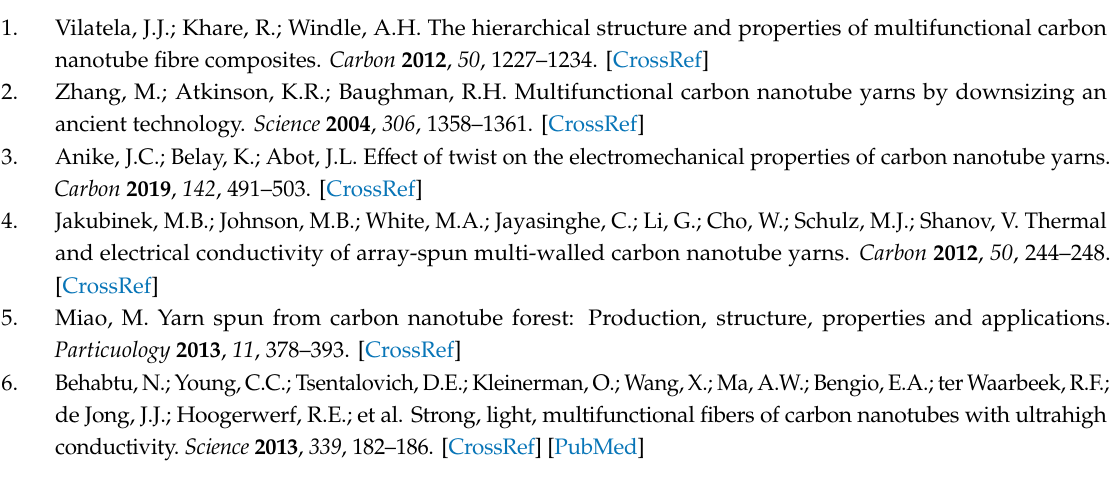
Figure S1: Rheometry characterization of epoxy resins, Figure S2: Onset of zone III of freestanding CNTY using the same temperature program as for the CNTY / polymer experiment, Figure S3: Thermograms of specimens cured at